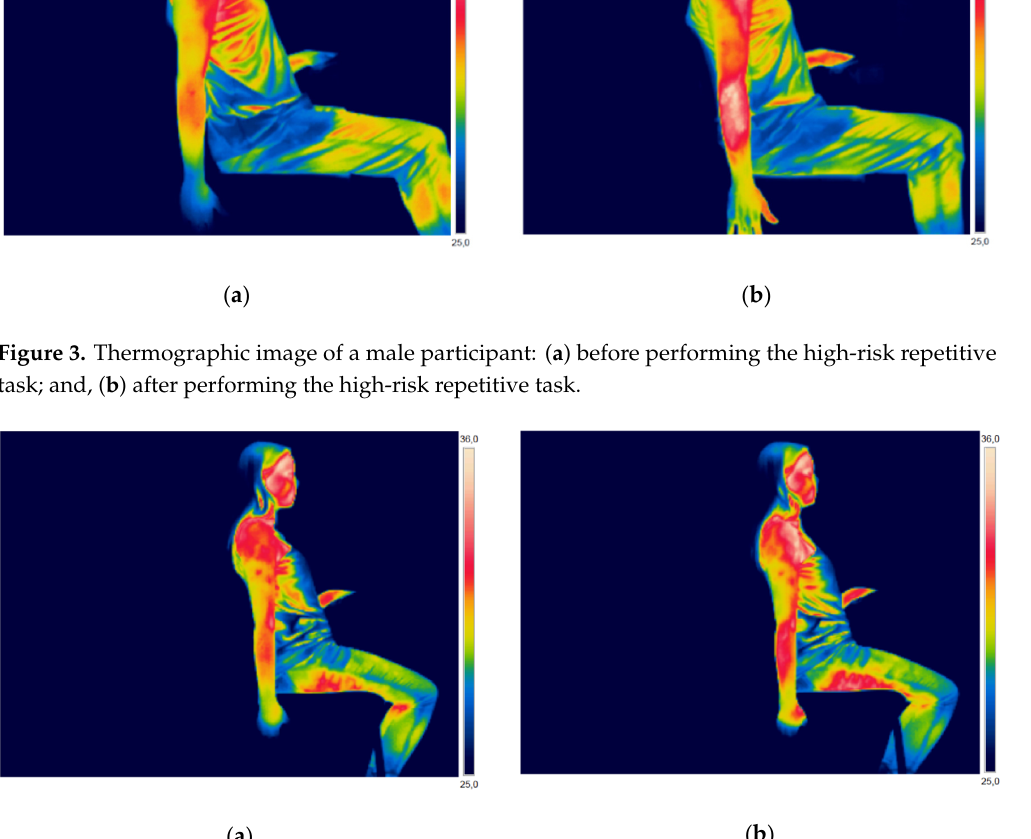
Table 6. Variation of shoulder skin temperature